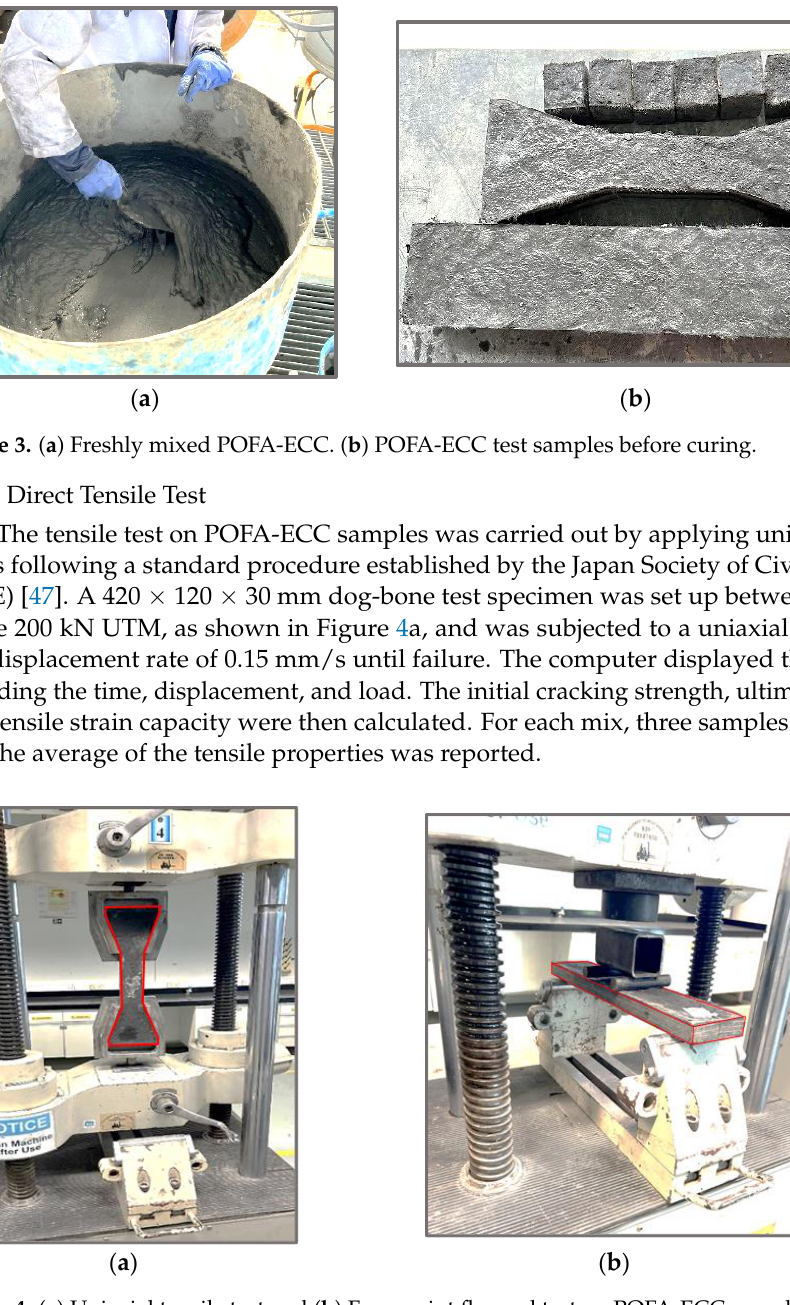
Figure 4. ( a ) Uniaxial tensile test and ( b ) Four-point flexural test on POFA-ECC samples.